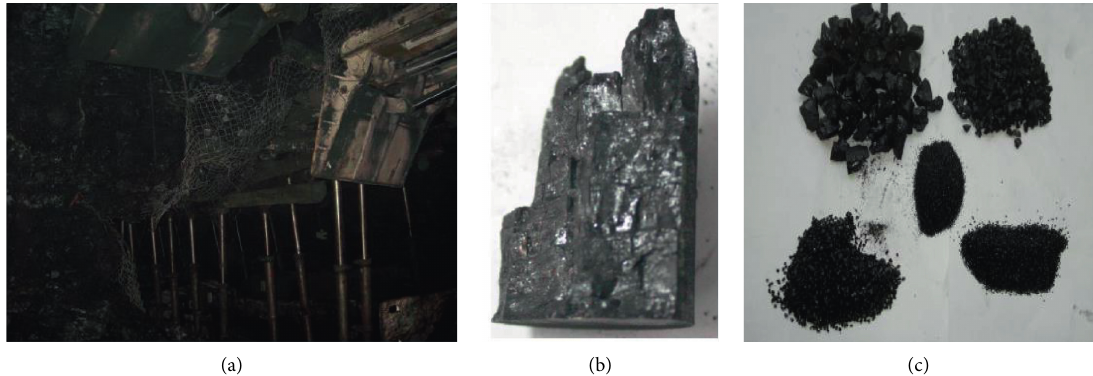
Figure 1: The fragmented coals: (a) ejected coal due to coal burst in front of the working face on site. (b) Quasistatic failure of the coal sample in the laboratory. (c) Dynamic failure of the coal samples in the